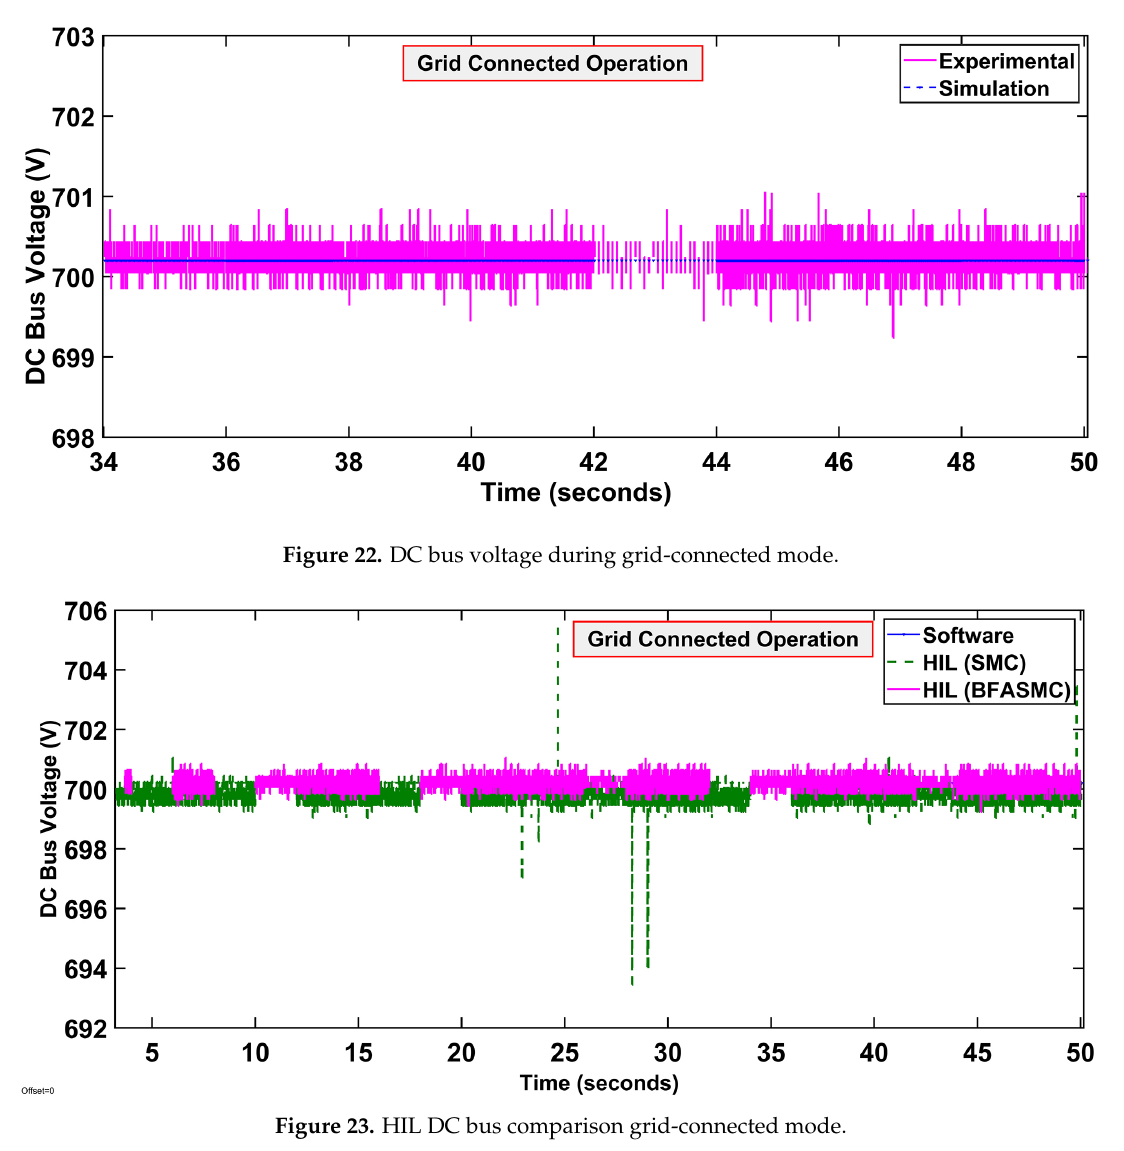
Figure 23. HIL DC bus comparison grid-connected